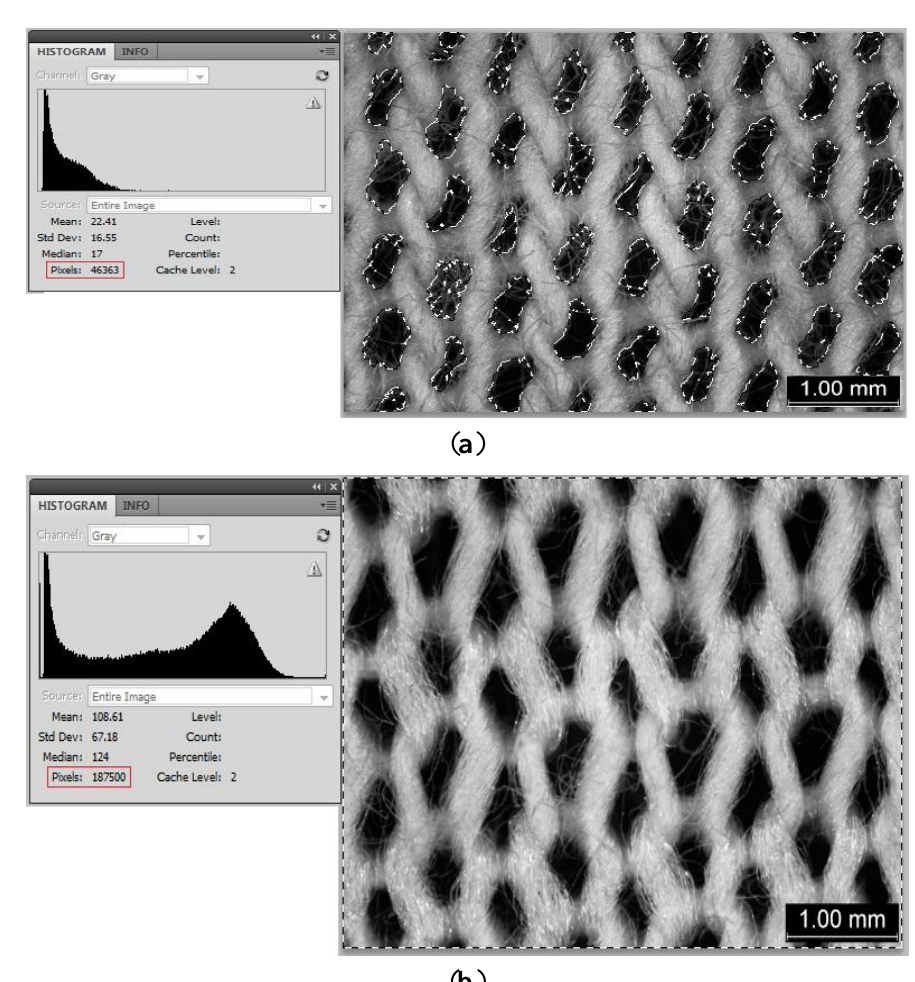
Figure 6. Number of pixels of ( a ) pores; and ( b ) whole